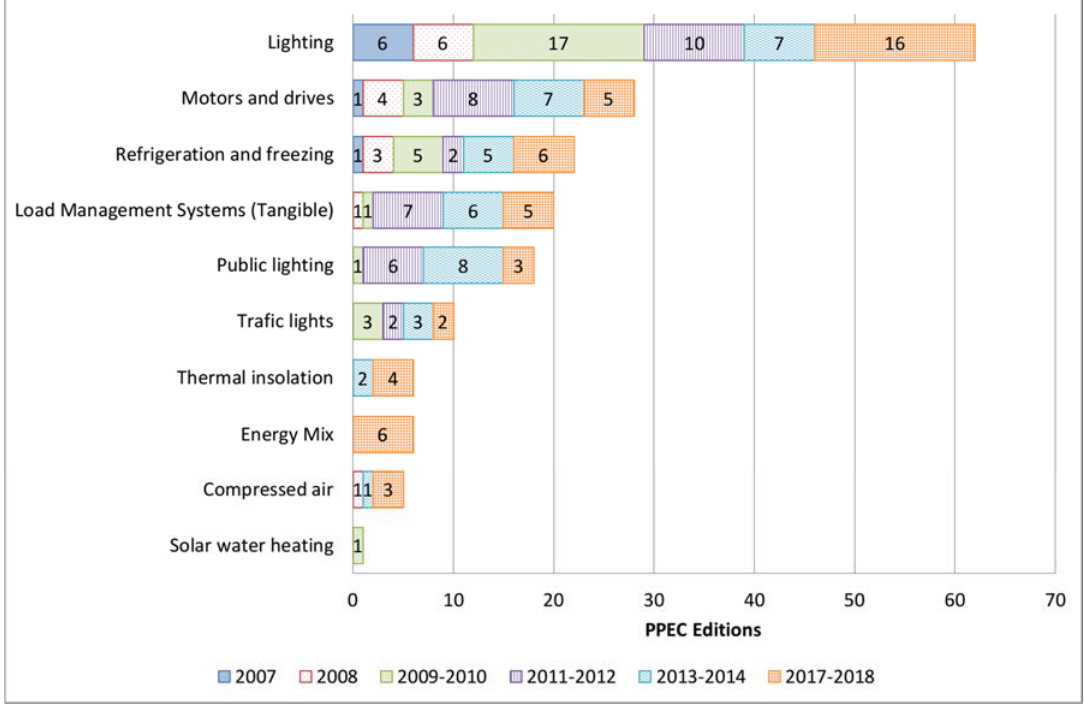
Figure 14. Number of selected measures, according to each energy services addressed, in each PPEC edition [19–26].